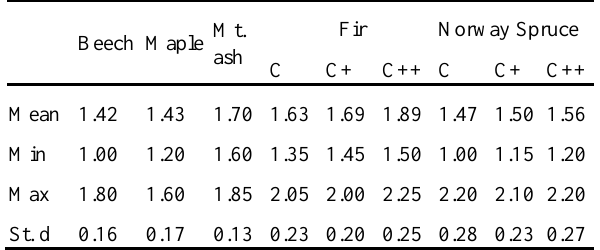
Table 3. Descriptive statistics of the structural parameter N values for sampled trees as retrieved by inversion of the PROSPECT-4 model at three selected wavelengths in the infrared region.